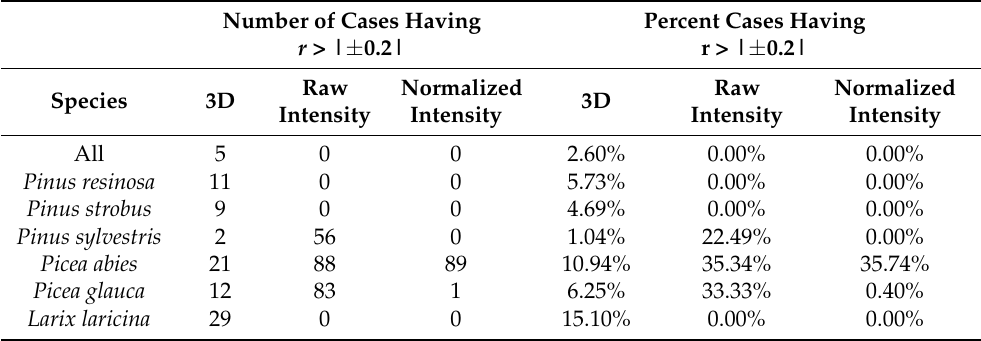
Table 5. Number and percentage of cases having a correlation ( r ) greater than | ± 0.2| between mean scan angle and feature values by species. Cases that were greater than 15% are shaded.